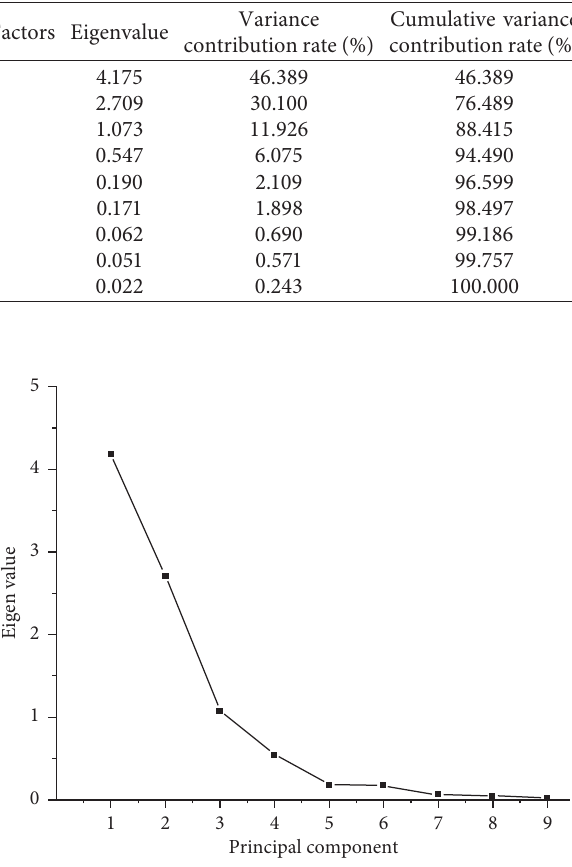
Figure 8: Scree Table 2. The load value represents the relationship between